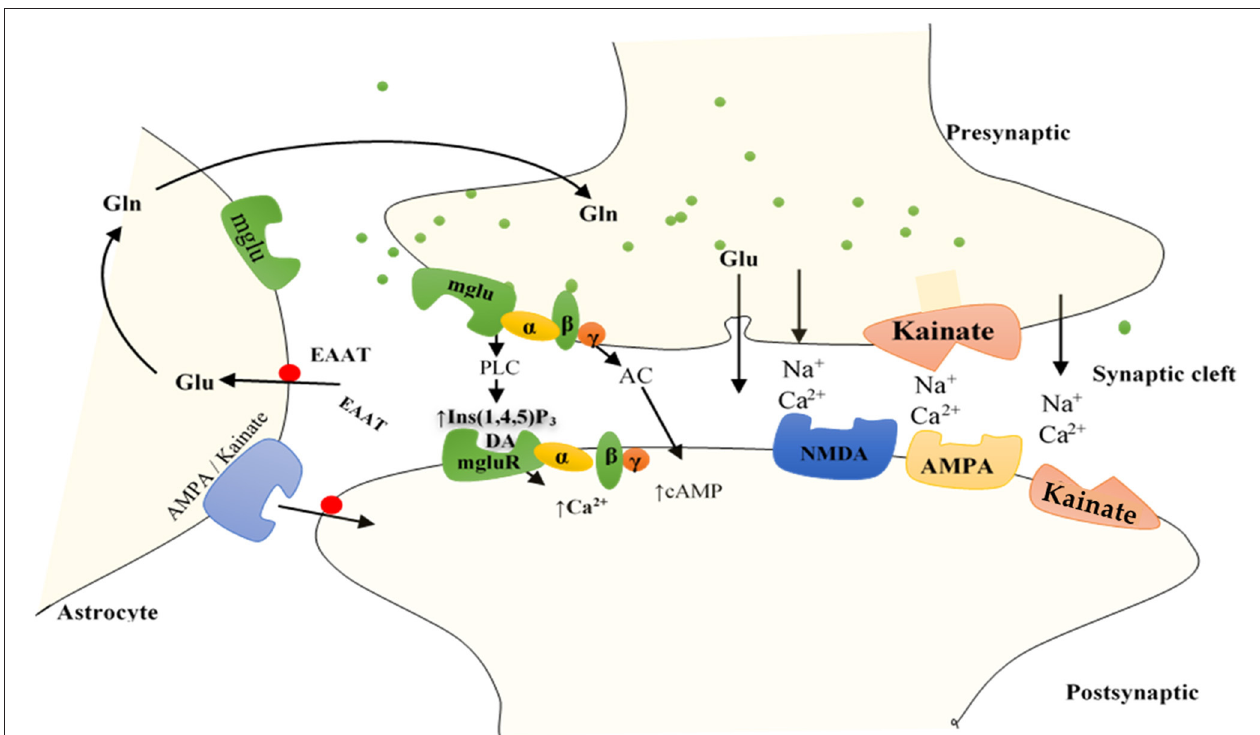
FIGURE 2 | Function of GluRs: Glutamate discharged from presynaptic neurons spread across the cleft of the synapse (by diffusion) to bind to receptors situated on the postsynaptic cell membrane. Group I mGluRs are affixed to PLC, whereas groups II and III receptors trigger the inhibitory cAMP pathway. IGluRs have permeability largely for Na + and Ca 2 + . Discharged glutamate is predominantly removed by specific excitatory amino acid transporters (EAATs) found on neighboring astrocytes. Accumulated glutamate inside the astrocytes is transformed to glutamine and transported to the presynaptic cell, which forms glutamate through mitochondrial glutaminase to be re-released. Astrocytes also express AMPA and kainate IGluRs, including mGluRs, bestowing evidence for bidirectional signaling of glutamate involving neurons and astrocytes. AC, adenylyl cyclase; DAG, diacylglycerol; Gln, glutamine; Glu, glutamate; Ins (1,4,5)P 3 , inositol (1,4,5)-trisphosphate.